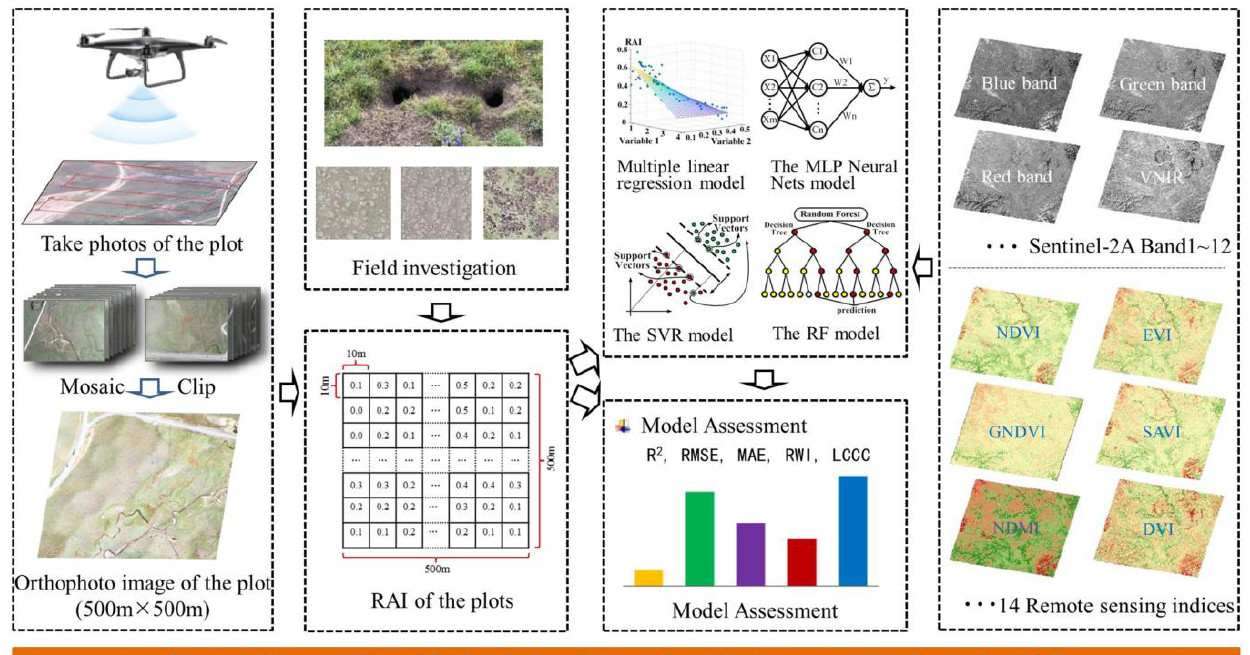
Figure 1. Study ideas and technical routes.